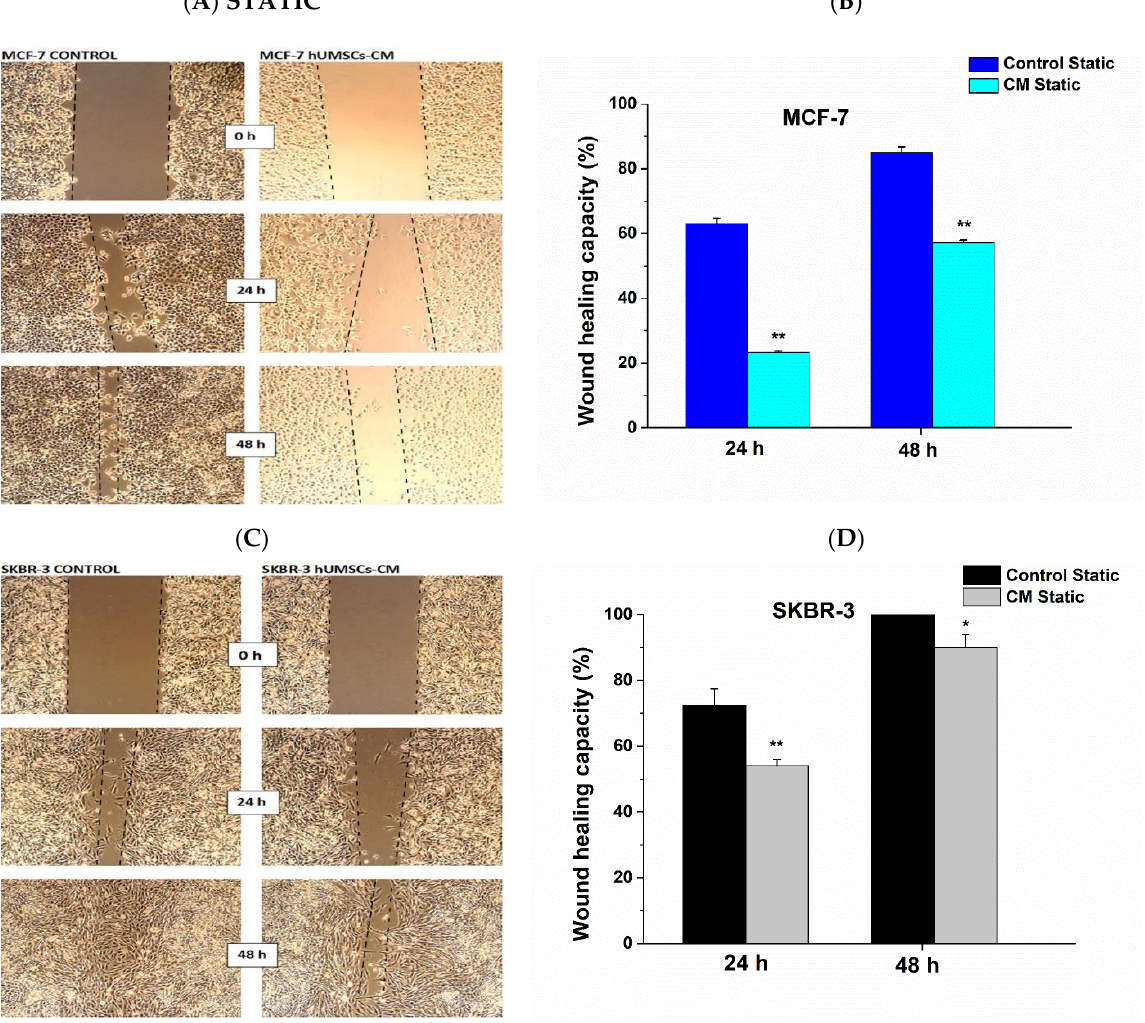
Figure 4. Quantitative analysis of the scratch-wound healing assay after 24 h and 48 h during static conditions. The proliferation of the MCF-7 ( A, B ) and SKBR-3 cells ( C, D ) was examined in the absence (control) and presence of hUMSCs-CM. Data represent mean values ± SD of three independent experiments were performed in both assays, * p < 0.05 and ** p < 0.01.